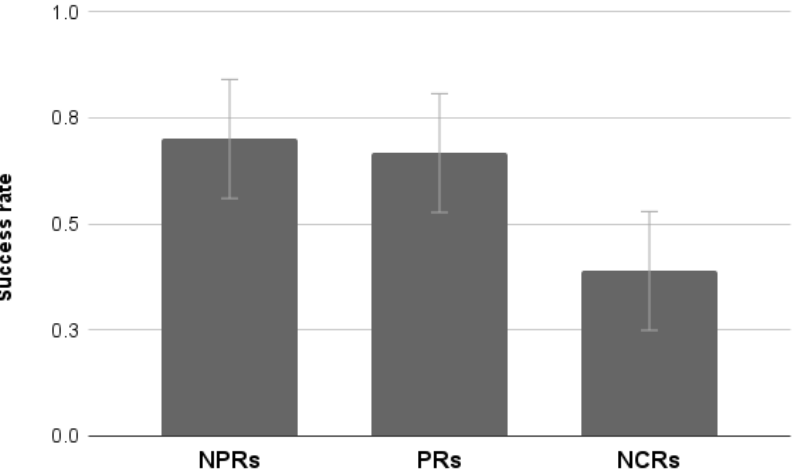
Figure 22. Success rate by Group (NPRs vs. PRs vs. NCRs). Error bars denote 0.95 confidence inter- vals.